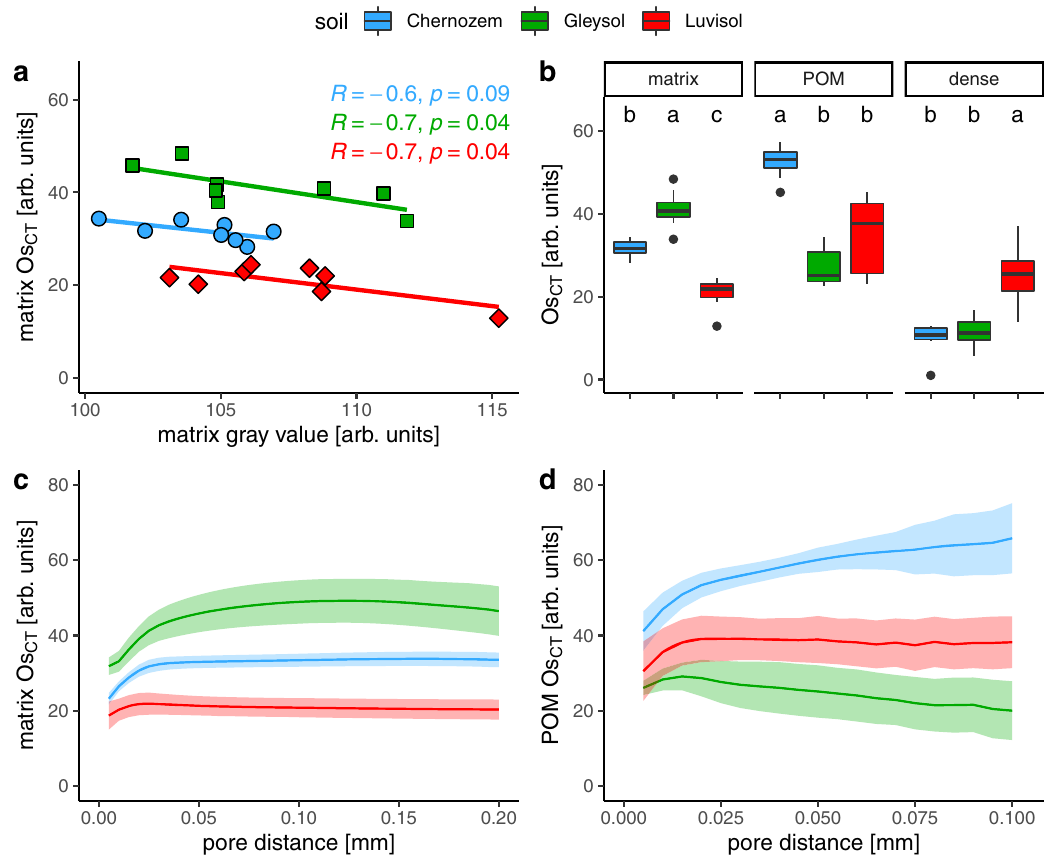
Fig. 5 Osmium concentrations (Os CT ) with respect to material classes and pore distances. a Linear relationship between Os concentration in the soil matrix as a proxy for mineral-associated organic matter and the soil matrix gray value prior to Os staining as proxy for bulk density. Both properties are given in arbitrary units resulting from grayscale normalization. b Average Os concentration in different material classes of each soil. The boxplots show the 0%, 25%, 50%, 75%, and 100% percentiles after outlier detection ( n = 8). Osmium concentrations in the soil matrix c and in POM d decline towards pore boundaries. Shaded areas represent two standard errors in each direction ( n =